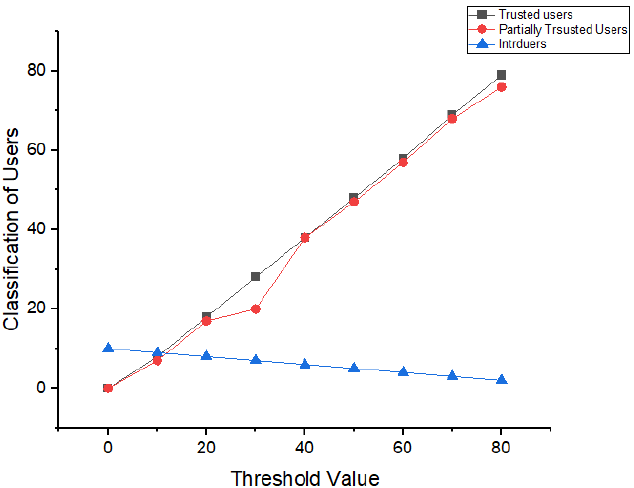
Figure 15. Using machine learning techniques to classify users’ trust according to their behaviors and